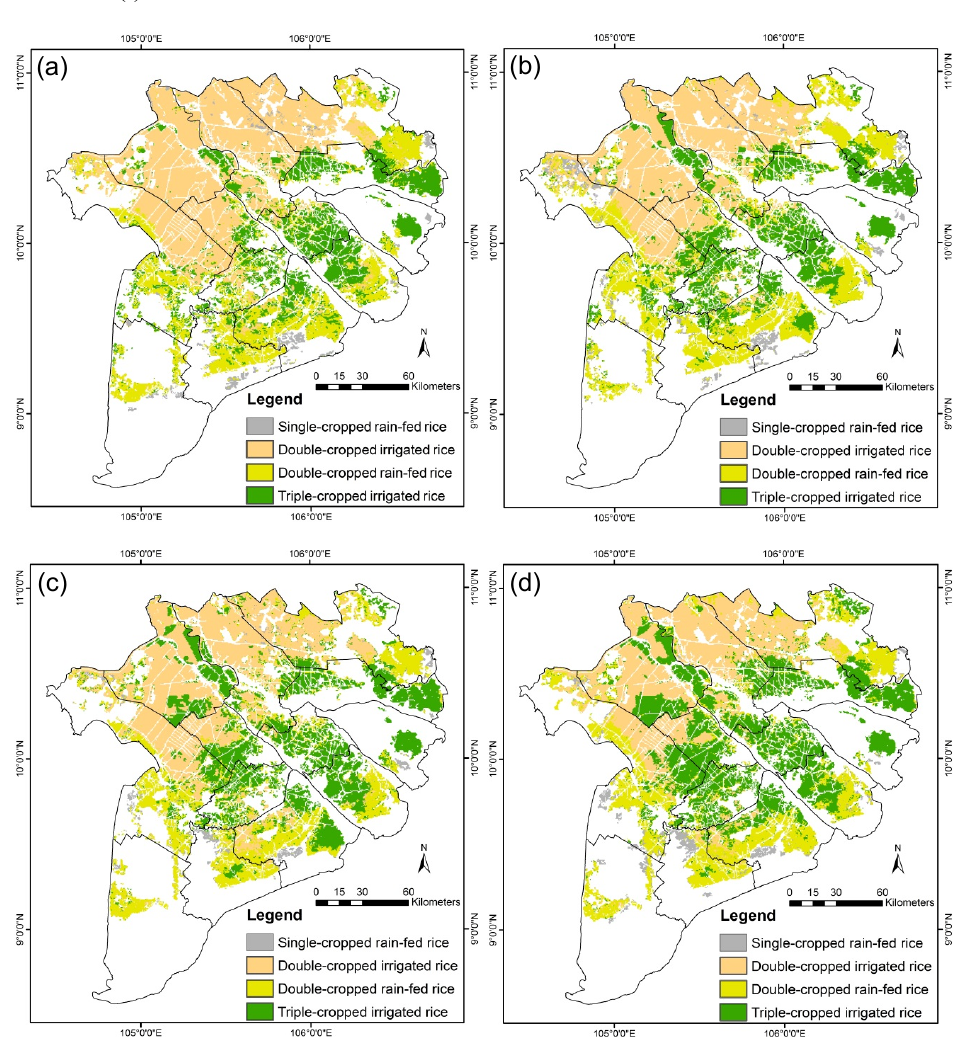
Figure 8. Spatial distributions of rice cropping systems in the study area: ( a )